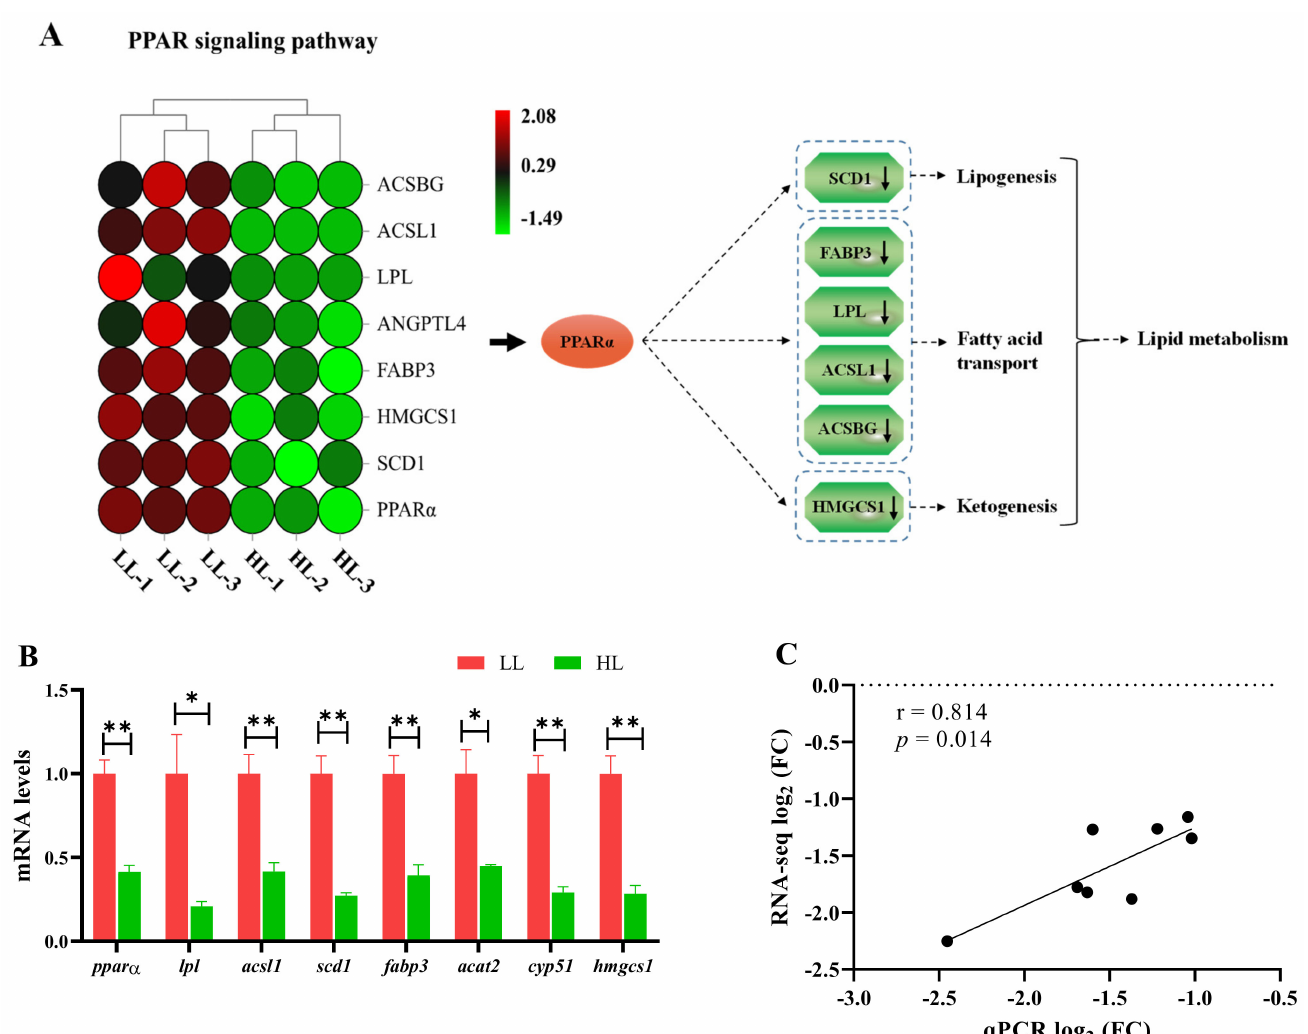
Figure 6. Changes in the PPAR signaling pathway and lipid metabolism-related genes in the liver of M. salmoides between the low-density group (LL) and the high-density group (HL). ( A ) DEGs in the KEGG PPAR signaling pathway and possible mechanisms regulating lipid metabolism. ( B ) Lipid metabolism-related gene expression measured by qPCR; values are expressed as means ± SEM (n = 3), * p < 0.05 and ** p < 0.01. ( C ) The correlation between the qPCR data and RNA-seq